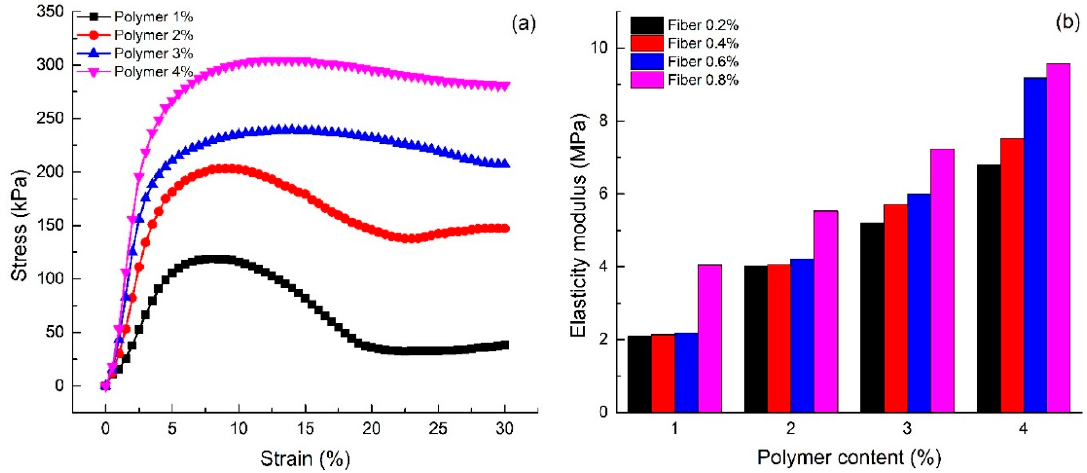
Figure 5. Effect of polymer content on unconfined compression test: ( a ) Stress-strain curves; ( b ) Elasticity modulus.